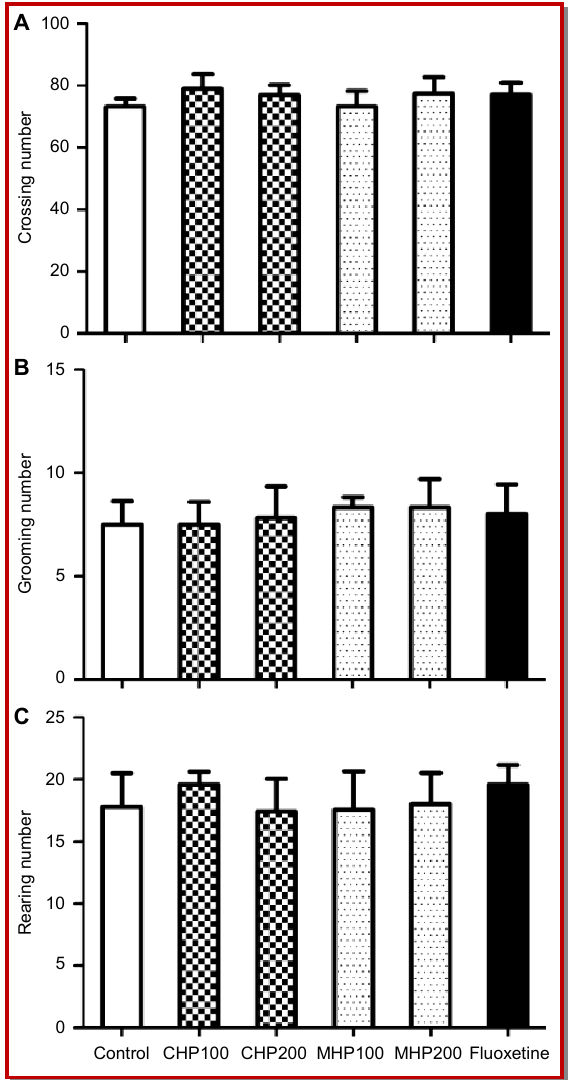
Figure 2: Effects of H. patens extracts (100 and 200 mg/kg), or fluoxetine (10 mg/kg) for 7 days administration on the number of crossing, rearing and grooming in open field test. The results are expressed as the mean ± SEM, n=6 in each group. (CHP- Chloroform extract of H. patens , MHP-Methanol extract )